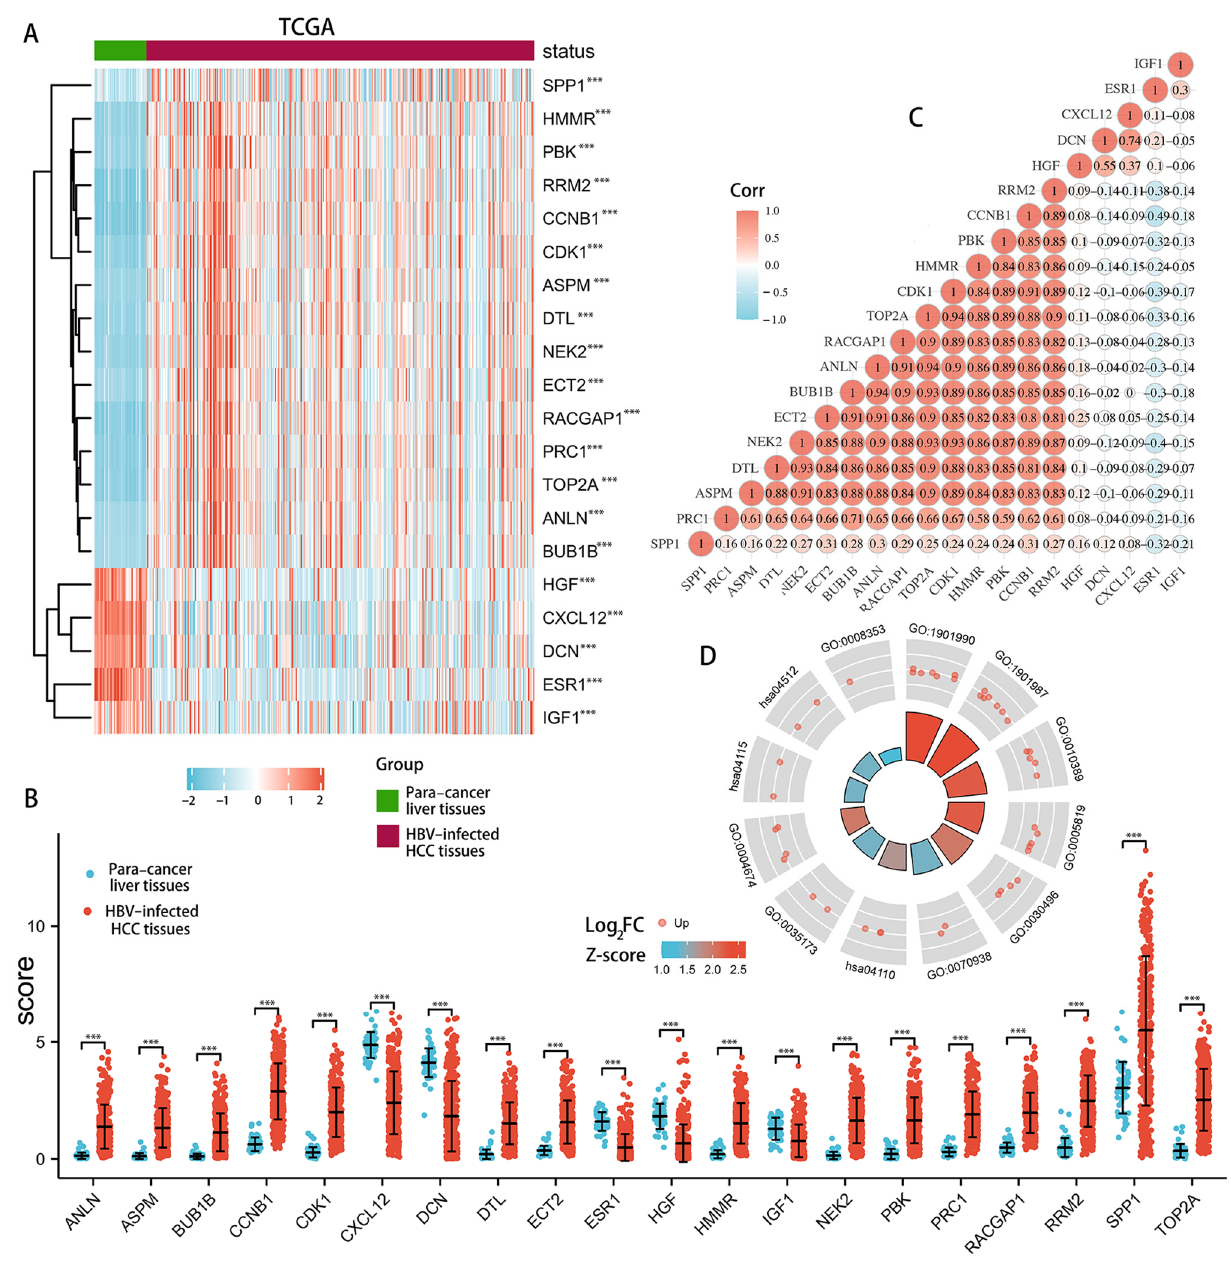
Figure 5. Expression validation of candidate hub genes in TCGA database. Heatmaps of hub genes expressed in tumors and adjacent normal tissues in patients with HCC ( A ). Validation of the expression level of hub genes in patients with HCC ( B ). The correlation matrix of interaction in hub genes. Correlation coefficients are plotted with negative correlation (blue) and positive correlation (red) ( C ). Functional enrichment analysis of the up-regulated hub genes ( D ). GO 1901990: regulation of mitotic cell cycle phase transition; GO 1901987: regulation of cell cycle phase transition; GO 0010389: regulation of G2/M transition of the mitotic cell cycle; GO 0005819: spindle; GO 0030496: midbody; GO 0070938: contractile ring; GO 0004674: protein serine/threonine kinase activity; GO 0008353: RNA polymerase II CTD heptapeptide repeat kinase activity; hsa04110: cell cycle; hsa04115: p53 signaling pathway; hsa04512: ECM–receptor interaction. *** p <